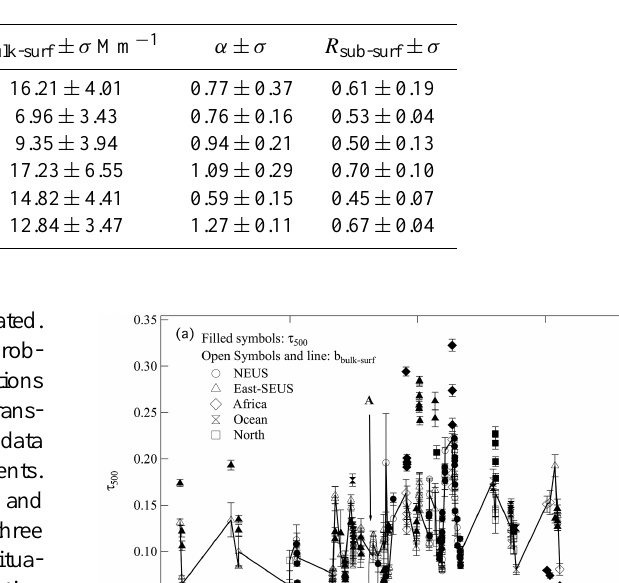
Table 2. Monthly average values of τ 500 , b bulk-surf , α , and R sub-surf with standard deviation ( σ ). Number of hourly average data (N) used to get monthly average aerosol data are reported in parentheses in the second column.